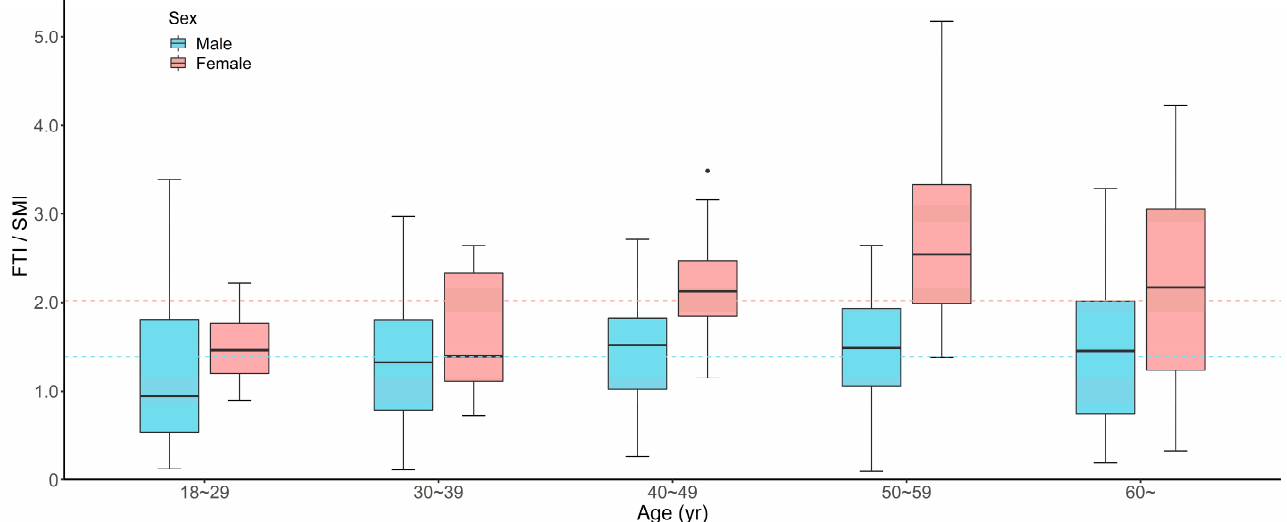
Figure 4. Box plots showing differences in FTI/SMI according to sex and age. The blue and red dashed lines represent the median FTI/SMI for male (1.39) and female (2.02) patients, respectively. FTI, fat tissue index; SMI, skeletal muscle index.